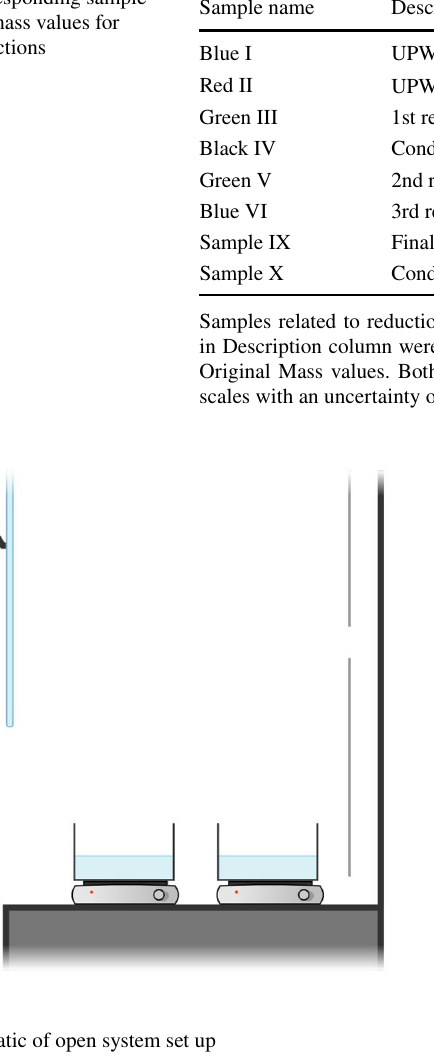
Table 1 Corresponding sample and original mass values for different reductions